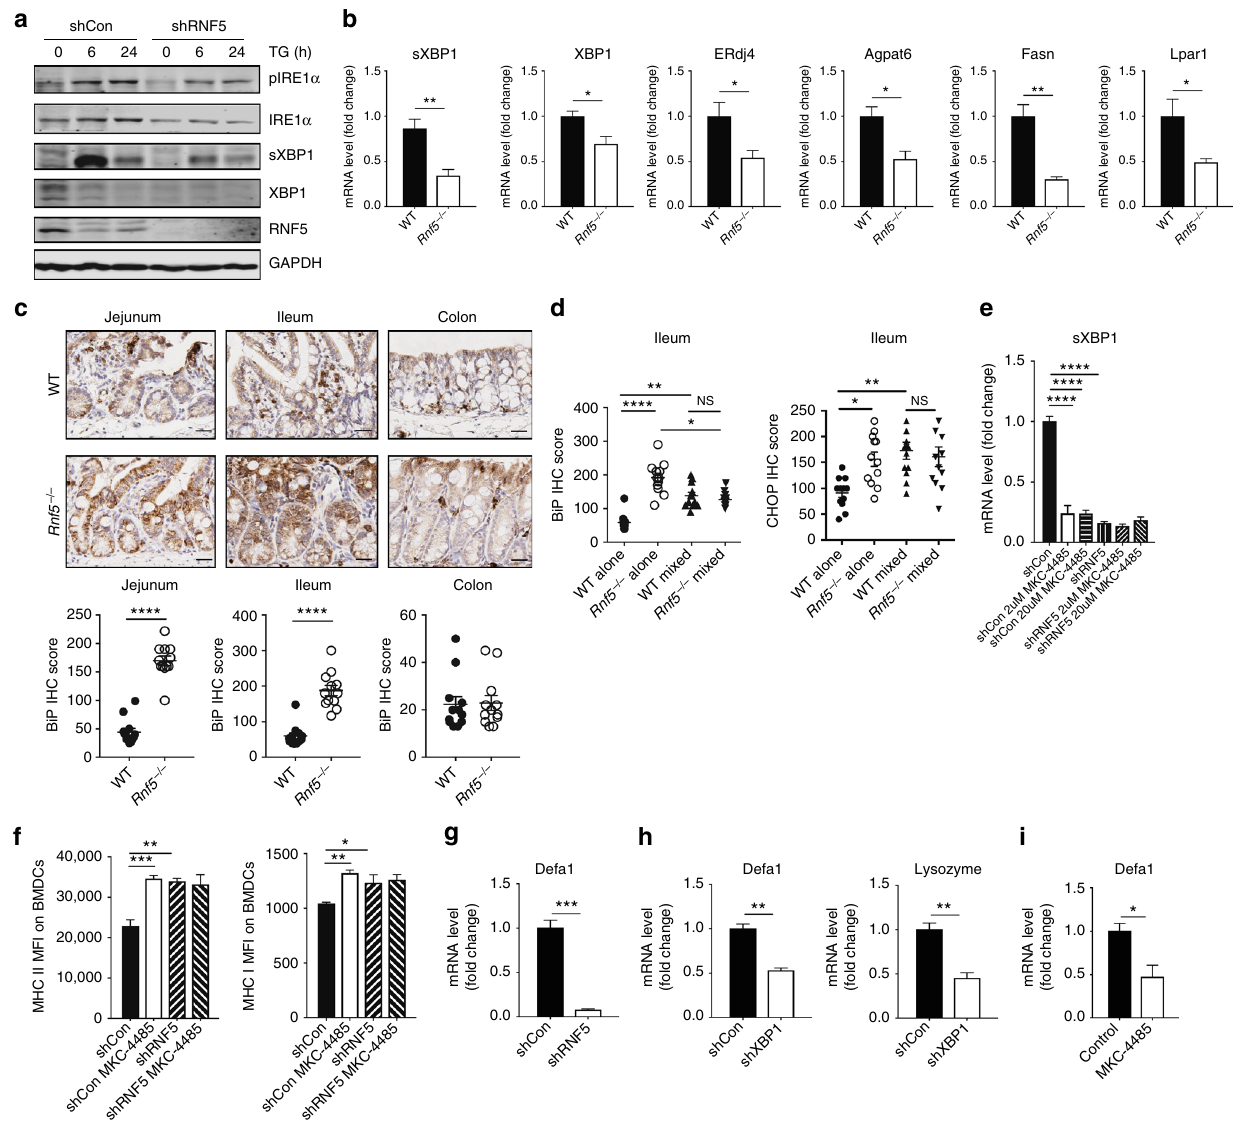
Fig. 6 IEC of Rnf5 − / − mice activate immune responses and changes AMPs expression by IRE1 α /sXBP1 signaling. a Western blot analysis of the indicated proteins in lysates of MODE-K-shCon and MODE-K-shRNF5 cells treated with thapsigargin (TG, 1 μ M) for indicated time. b qRT-PCR analysis of mRNA levels of sXBP1, XBP1 and target genes in small intestine-derived IECs from naive WT or Rnf5 − / − mice ( n = 4). c Representative micrographs of immunohistochemical (IHC) staining of BiP in the jejunum, ileum, and colon of YUMM1.5 tumor-bearing WT or Rnf5 − / − mice (scale bar = 25 μ m). Lower graphs show quanti fi cation of IHC staining ( n = 12 fi elds per group). Staining was scored semi-quantitatively based on staining intensity (0, 1, 2, or 3) multiplied by the percentage of positively stained cells (0 – 100), to give a maximum IHC score of 300. d Quanti fi cation of BiP and CHOP IHC staining in ileum sections from WT and Rnf5 − / − mice co-housed for 4 weeks prior to tumor inoculation ( n = 12). e qRT-PCR analysis of sXBP1 mRNA levels in MODE- K-shCon and MODE-K-shRNF5 cells treated with the indicated concentration of MKC-4485 for 24 h ( n = 3). f MFI of MHC class I and II on bone marrow- derived dendritic cells (BMDCs) incubated with media alone (no stimulation), conditioned media (CM) from shControl or shRNF5 MODE-K cells treated with MKC-4485 ( n = 4). g qRT-PCR analysis of Defa1 mRNA levels in MODE-K-shCon and MODE-K-shRNF5 cells ( n = 3). h qRT-PCR analysis of AMPs mRNA levels in IECs in MODE-K-shCon and MODE-K-shXBP1 cells ( n = 3). i , qRT-PCR analysis of Defa1 mRNA levels in MODE-K cells treated with 2 μ M MKC-4485 for 24 h ( n = 3). Data are representative of three independent experiments ( b , e – i ) and two independent experiments ( a , c , d ) ≥ 3 mice per group. Graphs show the mean ± s.e.m. * P < 0.05, ** P < 0.005, *** P < 0.001, **** P < 0.0001 by two-tailed t test or Mann – Whitney U test ( b , c , g – i ) or one- way ANOVA with Tukey ’ s correction for multiple comparisons ( d – f